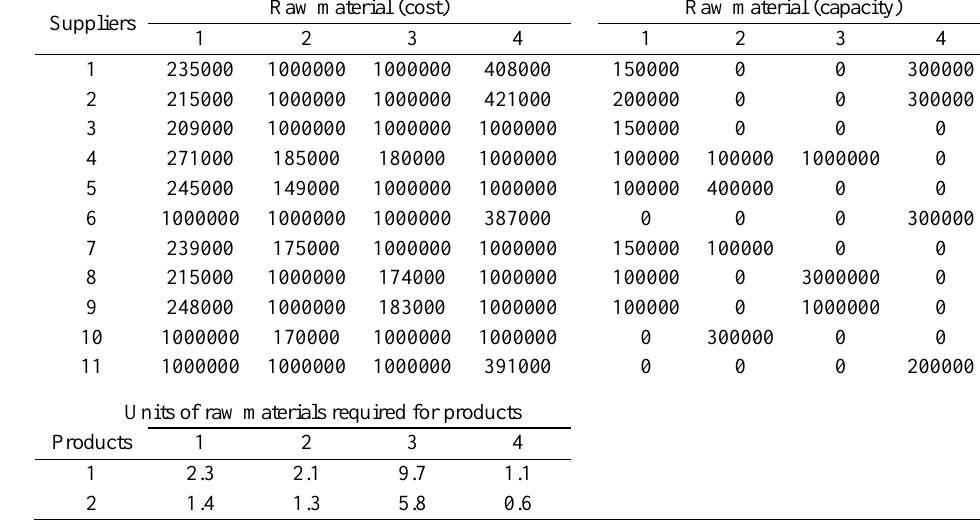
Table 5. Purchasing cost and capacity of suppliers for raw materials